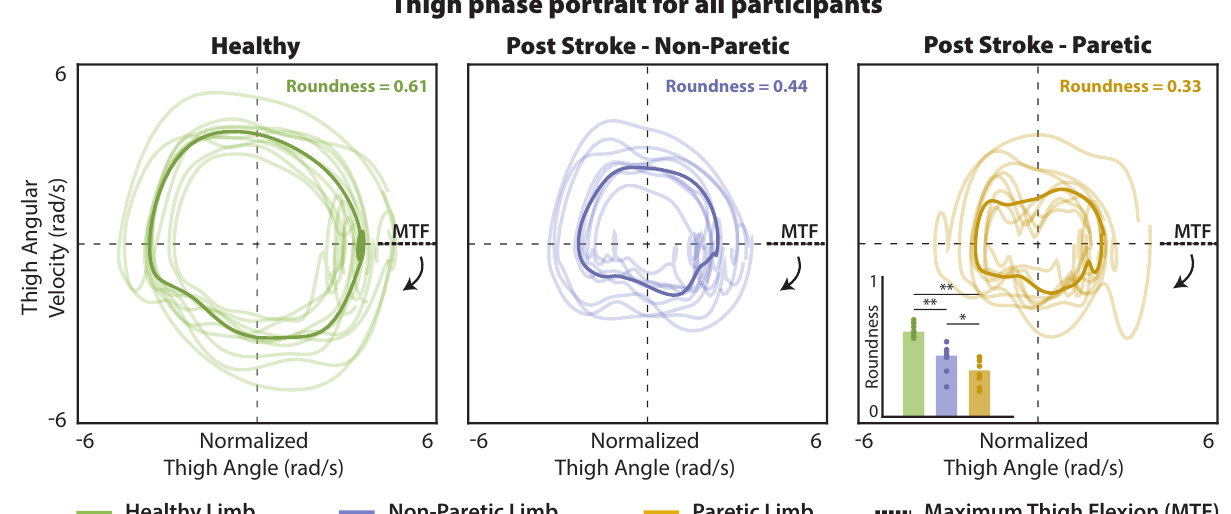
Figure 5. Thigh phase portraits used for speed estimation. The transparent lines in each panel are data from individual participants. The thick line in each panel is the average across participants. Subpanel: Comparison of the phase portrait roundness across groups. ** statistical significance ( p < 0.001), * statistical significance ( p =